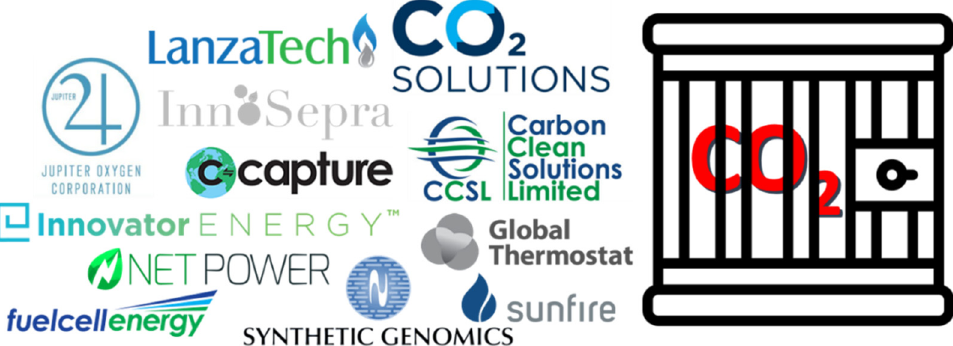
Figure 19. Main companies involved with the development of technologies for CO 2 capture and